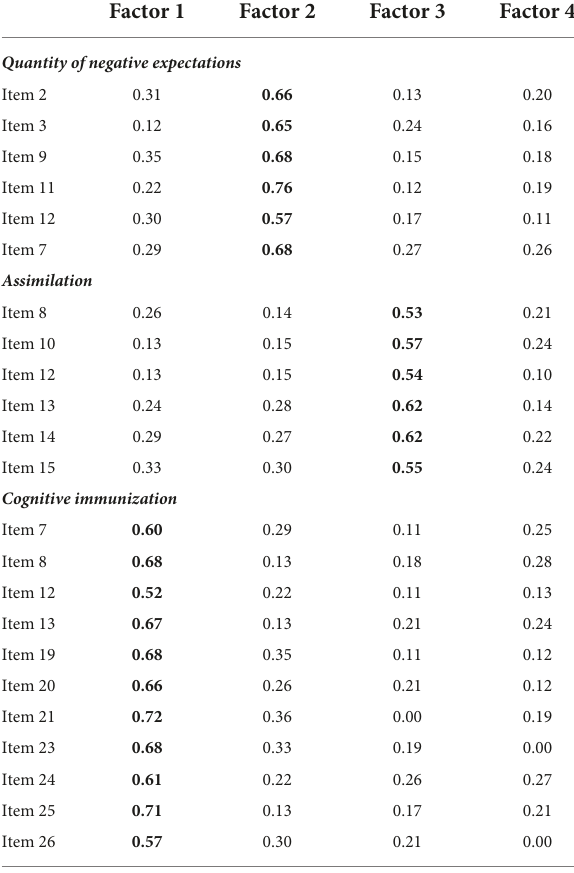
TABLE 2 Item loadings of the explorative (EFA) (study 1).